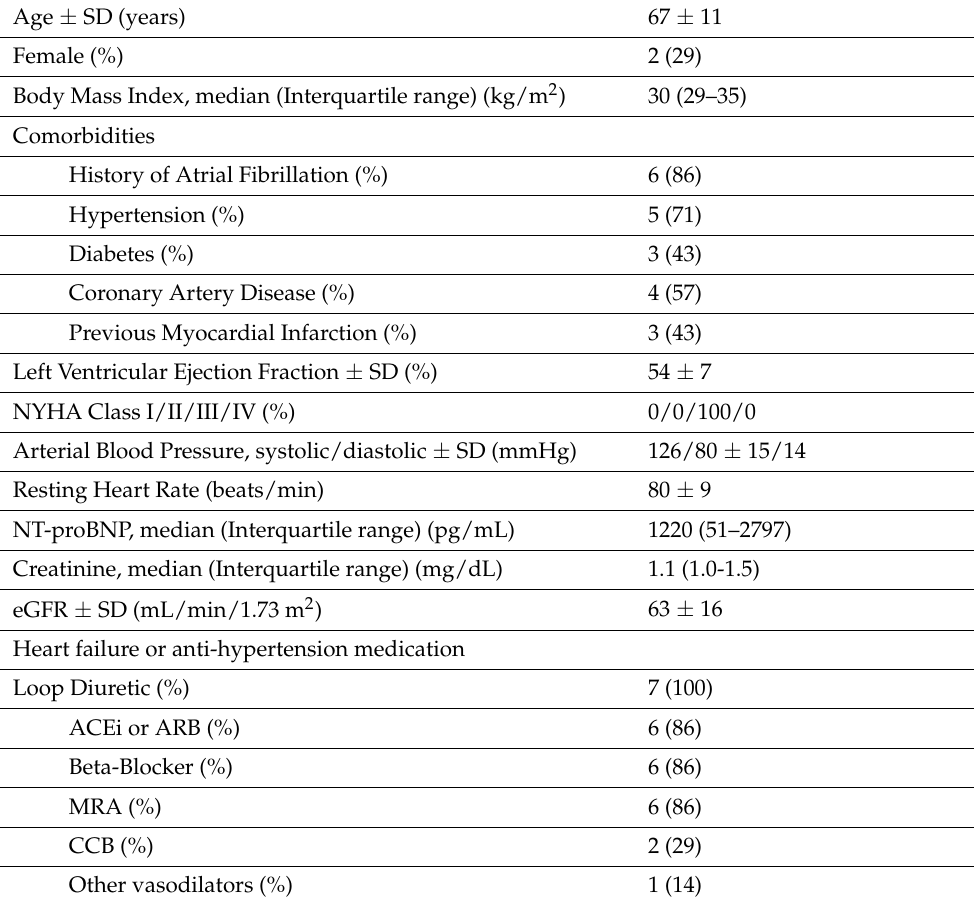
Table 1. Baseline demographic characteristics (n =